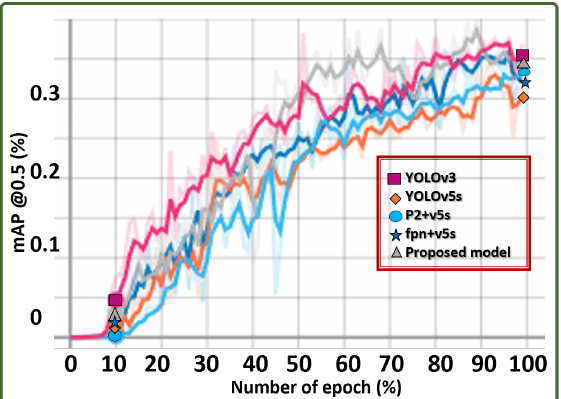
Figure 16. Hyperparameter graph showing the average precision of different models in identifying conveyed objects by